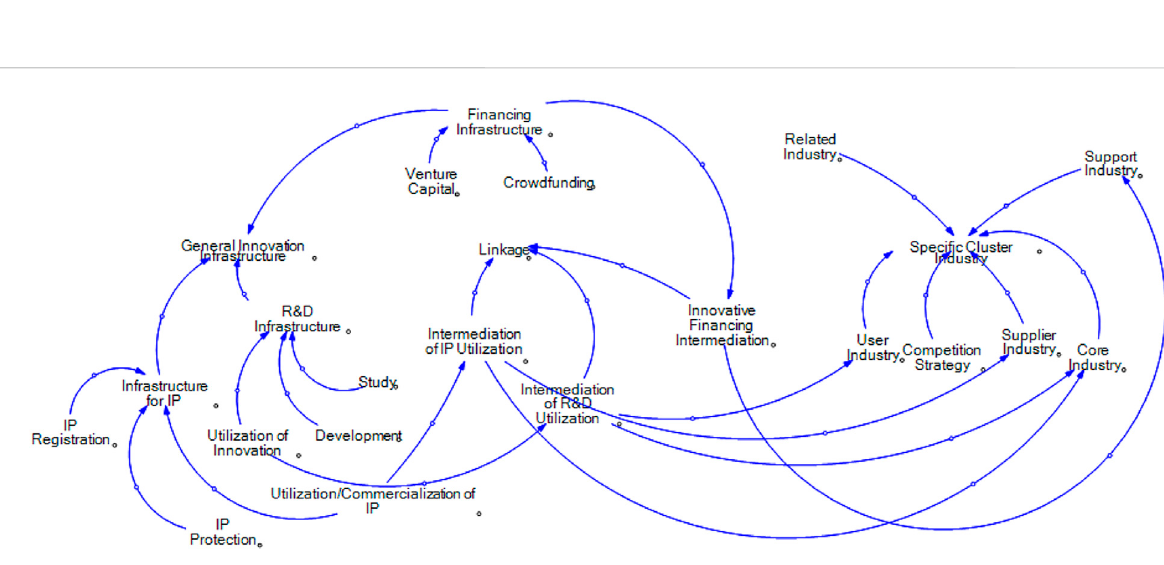
FIGURE 3 Causal loop diagram conceptualization source: Data Processing Results,